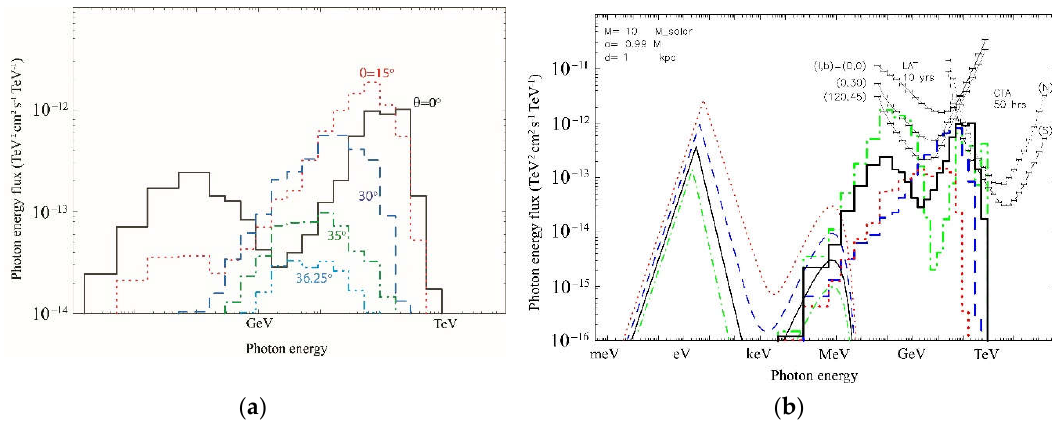
Figure 13. Spectral energy distribution (SED) of the gap-emitted photon for the BH whose mass and